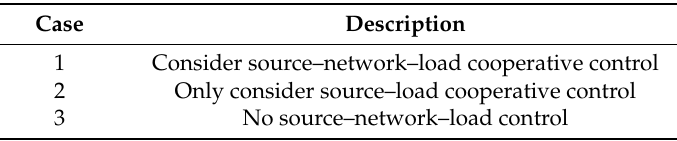
Table 1. Classification of simulation cases.